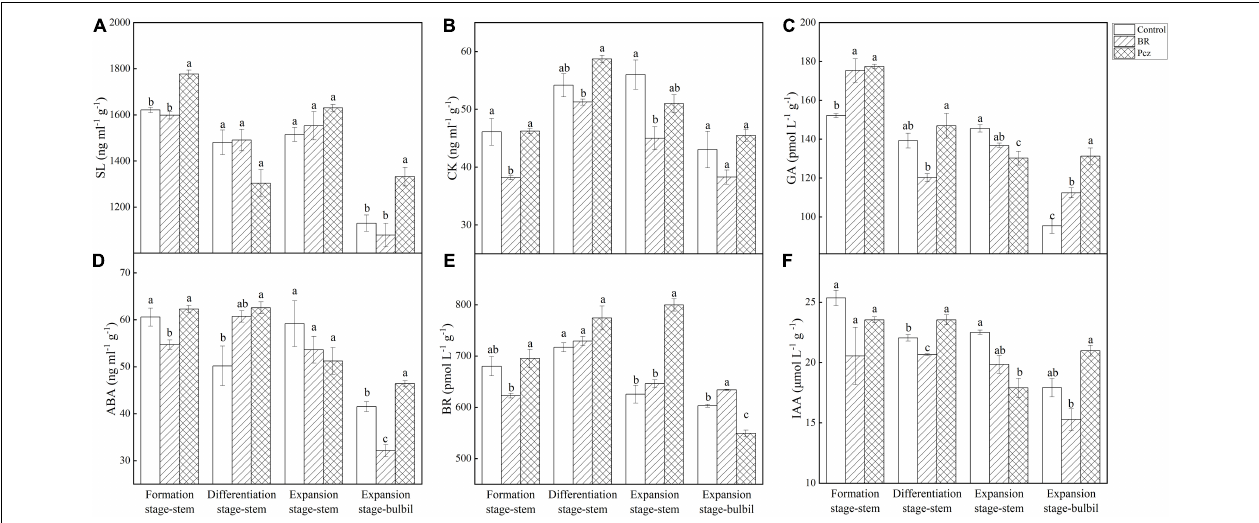
FIGURE 8 | The endogenous SL (A) , CK (B) , GA (C) , ABA (D) , BR (E) , and IAA (F) levels in bulbil of P. ternata under BR and Pcz treatments. The bars with different letters are significantly different from each treatment ( p < 0.05). Values are means of four replicates ±